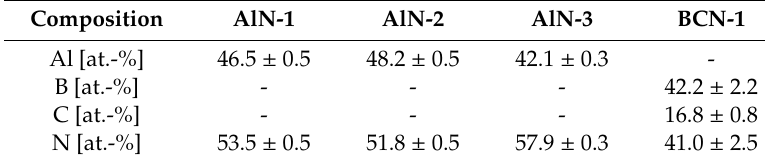
Table 2. Chemical composition of Aluminiumnitride (AlN) and Boron-Carbonitride (BCN) thin films. Composition